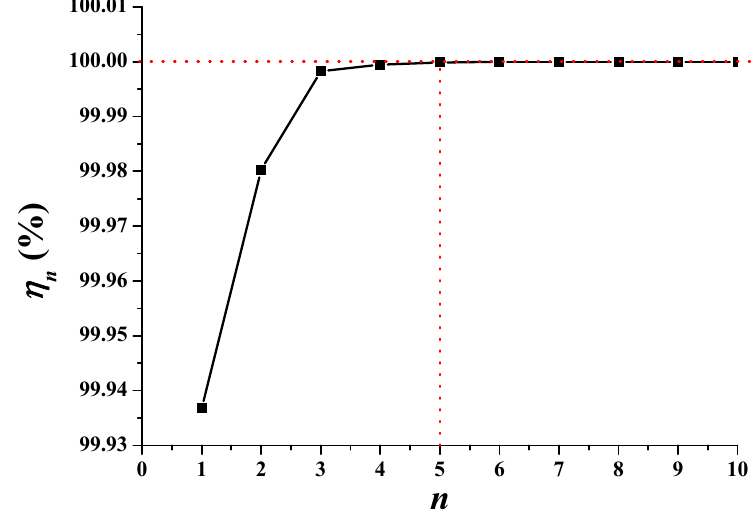
Figure 6. Cumulative energy contribution of the top n POD modes.